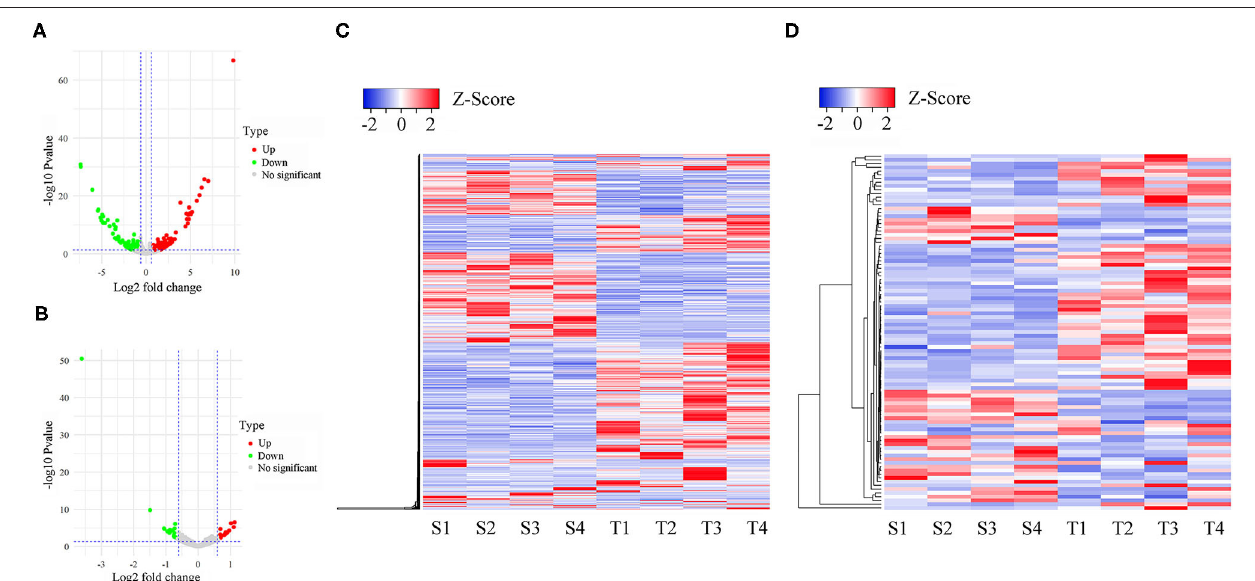
FIGURE 2 | Differentially expressed lncRNAs and mRNAs in susceptible and tolerant pigeons infected with Trichomoniasis gallinae . The volcano plot of differentially expressed lncRNAs (A) and mRNAs (B) . The significantly up- and down-regulated candidates are presented as red or green dots, respectively, the gray dots represent transcripts whose expression levels did not reach statistical significance (fold change > 1.5 and P < 0.05). (C) Cluster analysis of differentially expressed lncRNAs. (D) Cluster analysis of differentially expressed lncRNAs. S1–S4 denotes susceptible birds, and T1–T4 denotes tolerant